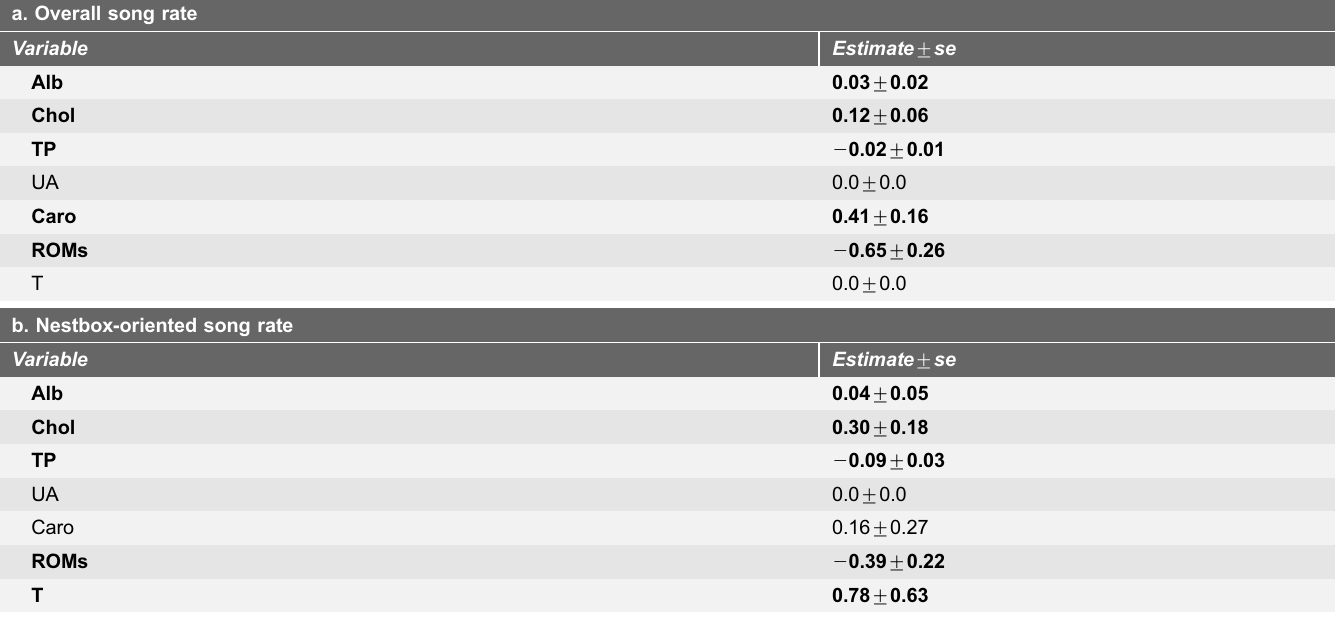
Table 2. Estimates related to the models of Table 1 describing the association between overall song rate (a) and nestbox-oriented song rate (b) with the physiological variables measured on day